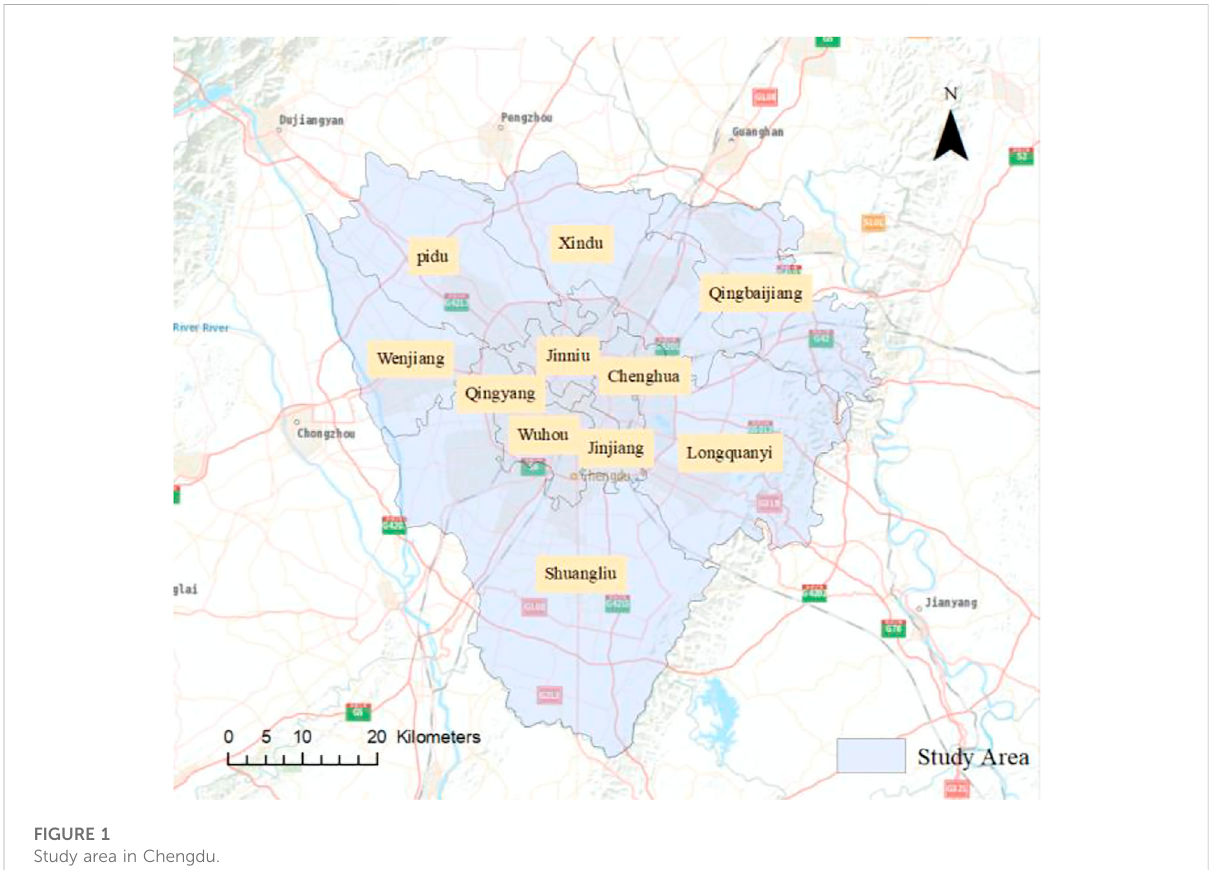
FIGURE 1 Study area in